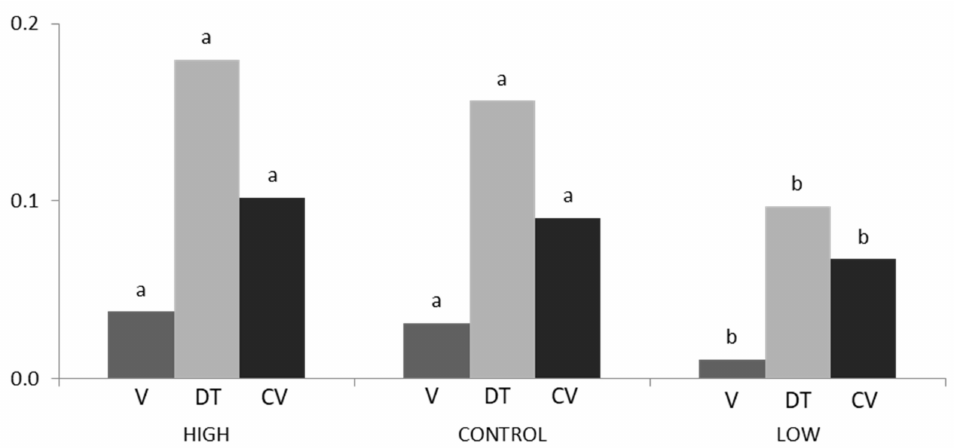
Figure 1. Variance (V), standard deviation (DT), and coe ffi cient of variation (CV) means of birth weight within litter for high, low, and control lines. Di ff erent letters show statistically significant di ff erences ( p <